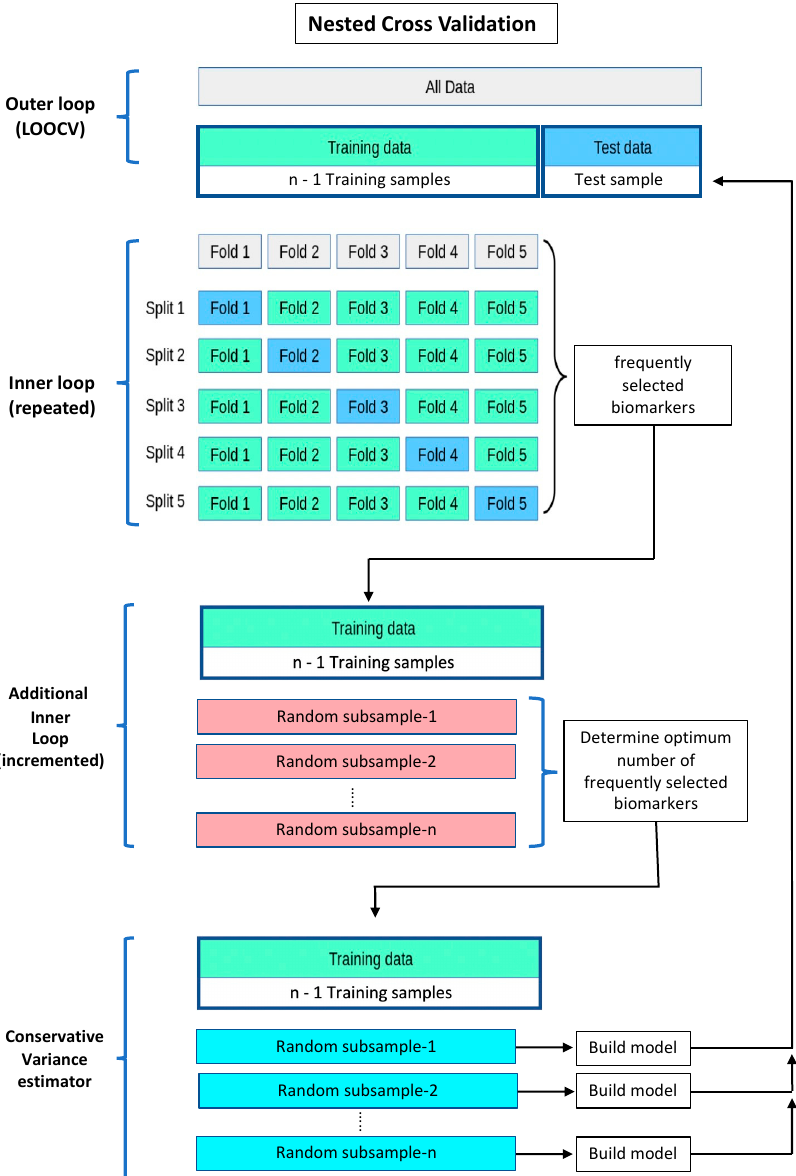
Scheme 1. Nested cross validation, with stable variable selection and conservative prediction error